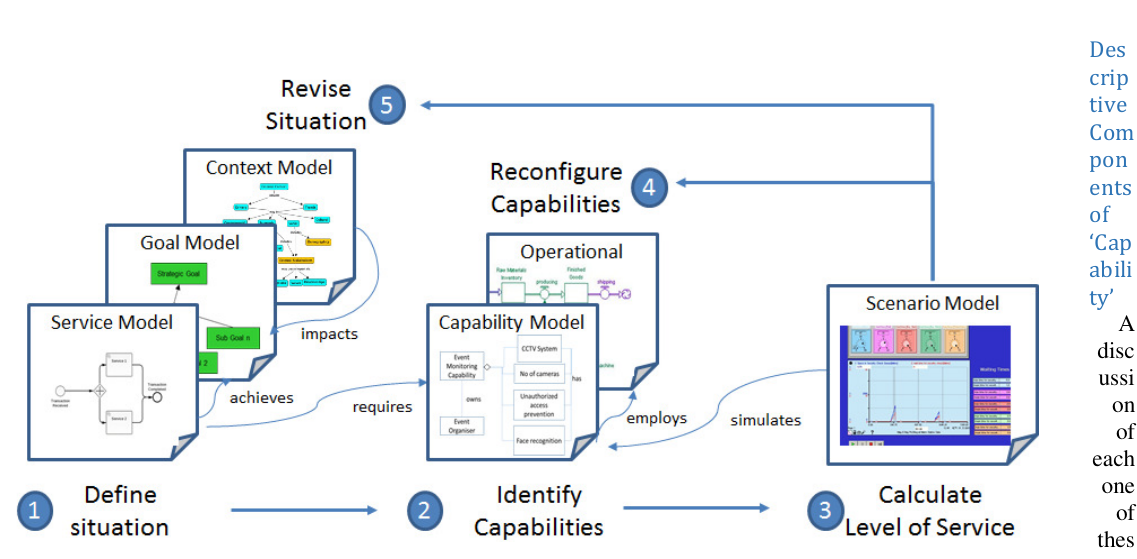
Figure 2: Process for modelling framework